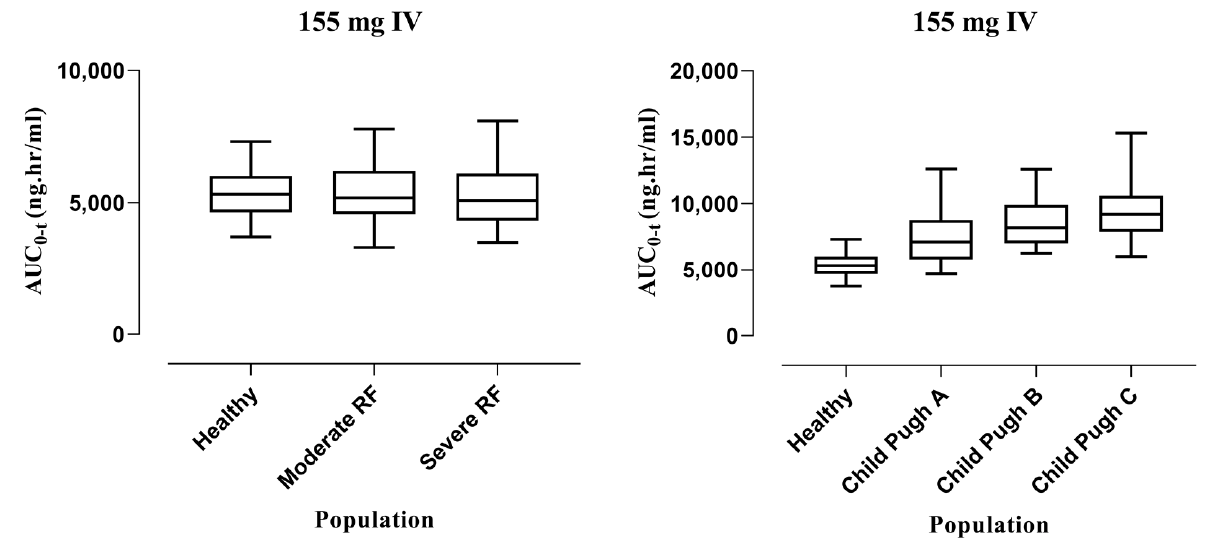
Figure 4. Box plots showing median with 5th–95th percentile after IV administration in liver cirrhosis and CKD.